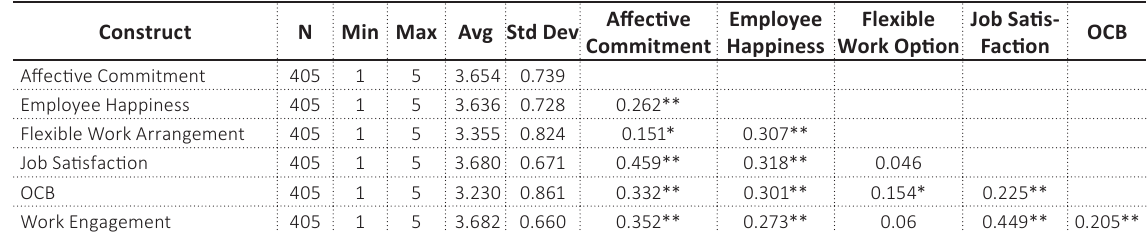
Table 1. Descriptive statistics and correlation among variables